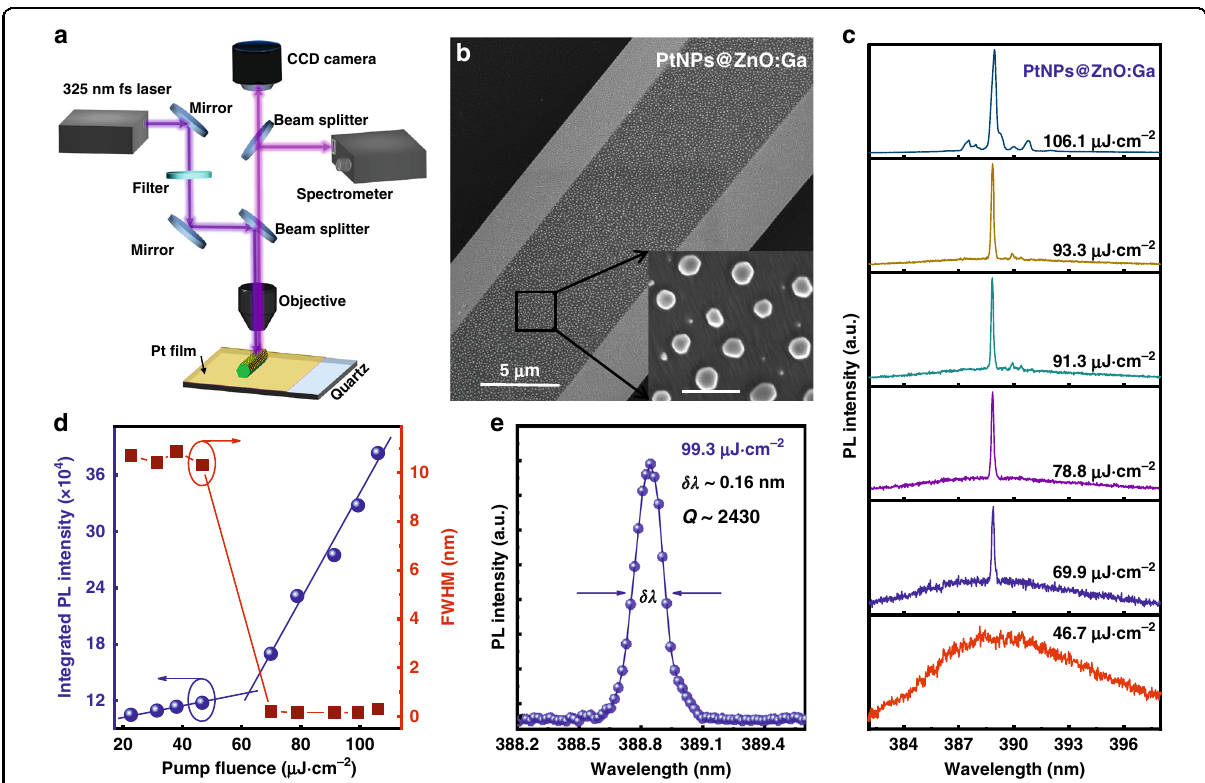
Fig. 4 Lasing characterization of an individual PtNPs@ZnO:Ga MW upon optically pumped. a Schematic showing the home-built micro-PL measuring equipment, in which the single ZnO:Ga MW covered by large-size PtNPs was pumped by a 325 nm fs-ampli fi ed laser. b SEM image of a single ZnO:Ga MW covered by PtNPs. Inset: Enlarged SEM image of the PtNPs, which are deposited on the side surface of ZnO:Ga MW. The diameter of the deposited PtNPs is extracted to about 130 nm. c PL emission spectra of an individual PtNPs@ZnO:Ga MW at different pump power densities below and above the threshold. d Integrated PL intensity and spectral linewidth of the lasing peak as a function of pump fl uence, yielding a threshold fl uence of P th ~ 66.2 μ J·cm − 2 . e Magni fi ed PL spectrum of the 388.5 nm lasing mode. The dots and line are experimental data and Lorentz function fi tting curve, respectively. The spectral FWHM of the lasing peak is extracted to about 0.16 nm, and the Q -factor value is calculated to